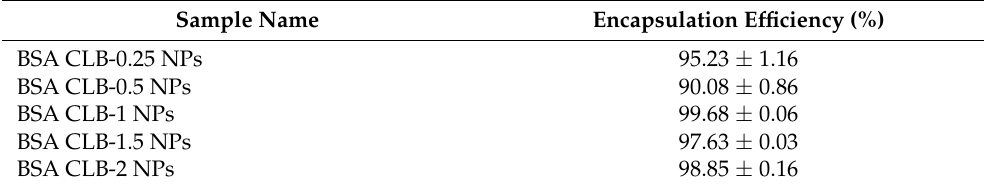
Table 1. Encapsulation efficiency ( n = 3; average ± RSD *).